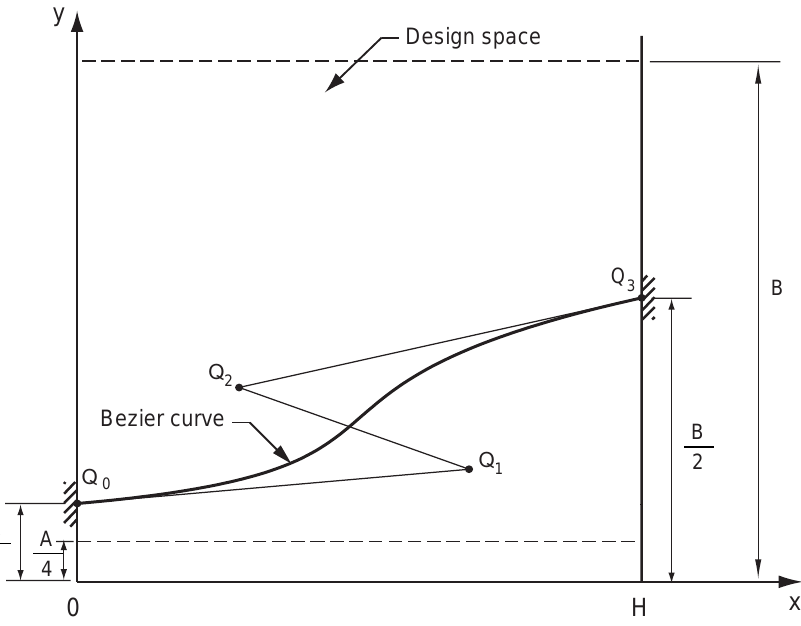
Q , Q , Q , and Q ). Figure 3. A profile of a B é zier plate and its four control points ( Q 0 , Q 1 , Q 2 , and Q 3 0 1 2 3